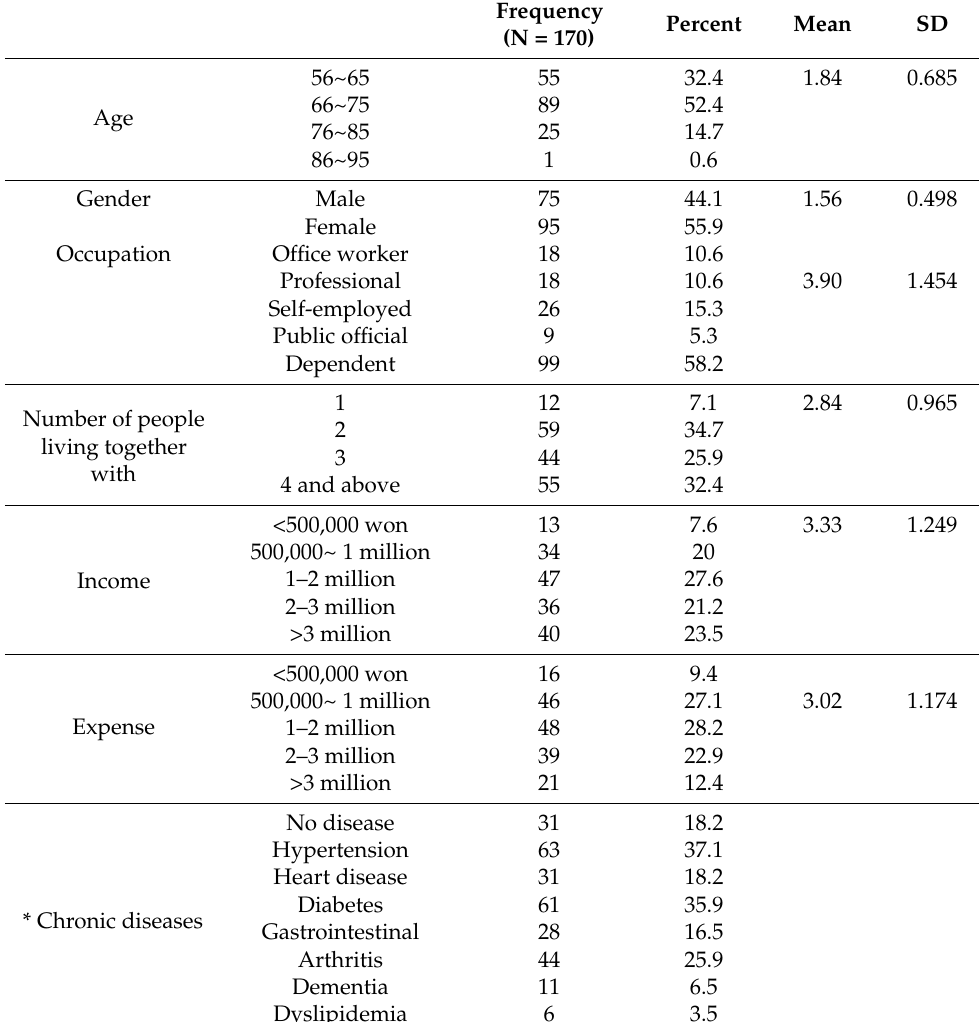
Table 2. Demographics of respondents (N =